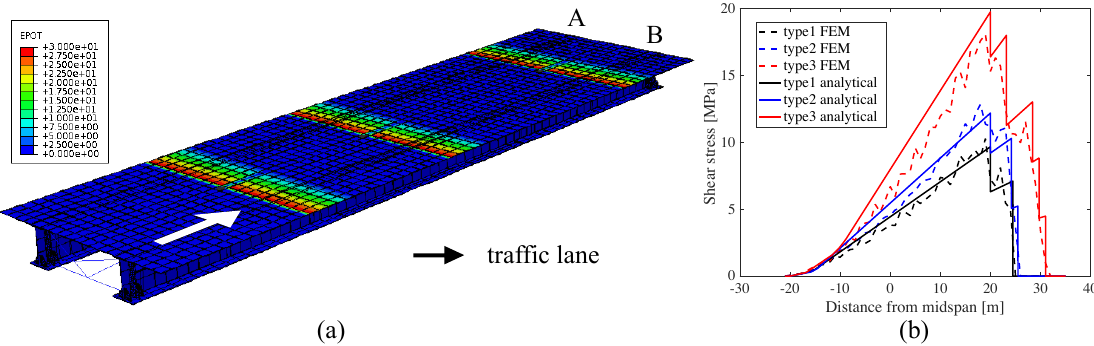
Figure 6. ( a ) Finite element model (FEM) of the bridge showing the change in potential along smart pavement sections, where smart pavement sections are under a charge of 30V, and ( b ) analytical versus numerical influence lines for the Von Mises Stress at the end of the